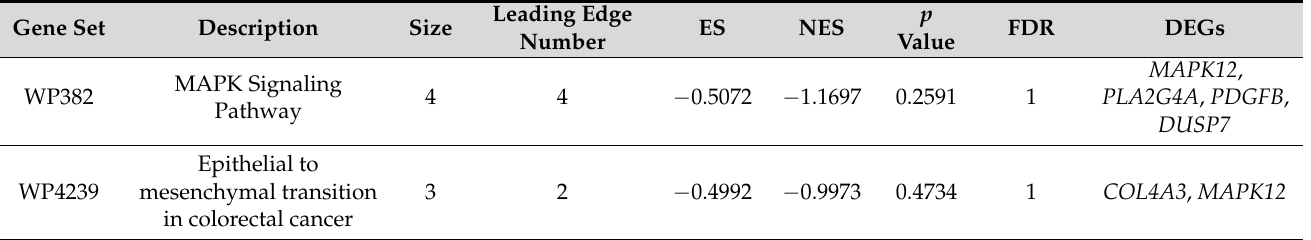
Figure 6. Pharmacologic inhibition of ASAH1 decreased migration-related pathways. To match conditions of the scratch assay, U251 cells were plated in 10% FBS, serum-starved in the presence of vehicle (DMSO) or 5 µM carmofur for 16 h, and changed to 10% FBS with new vehicle or carmofur for the final 24 h. Cells were collected for RNA-sequencing at the end of the 24 h treatment. ( A ) Visualization of RNA-sequencing by volcano plot of transcripts revealed that U251 cells treated with 5 µM carmofur displayed an altered pattern, relative to vehicle control ( n = 3). ( B ) GSEA for genes with log 2 FC > 0.5 or < − 0.5 analyzed using WebGestalt (http://www.webgestalt.org) (accessed on 4 December 2021) and compared to Wikipathway cancer with a 3 gene minimum/pathway. Gene input included those with a base mean > 5 and a p -value < 0.2. Table 2. Pharmacologic inhibition of ASAH1 suggested decreases in migration-related pathways. Table for GSEA analysis including ES, NES, p values, and FDRs for each pathway as well as differentially expressed genes (DEGs) for that pathway.